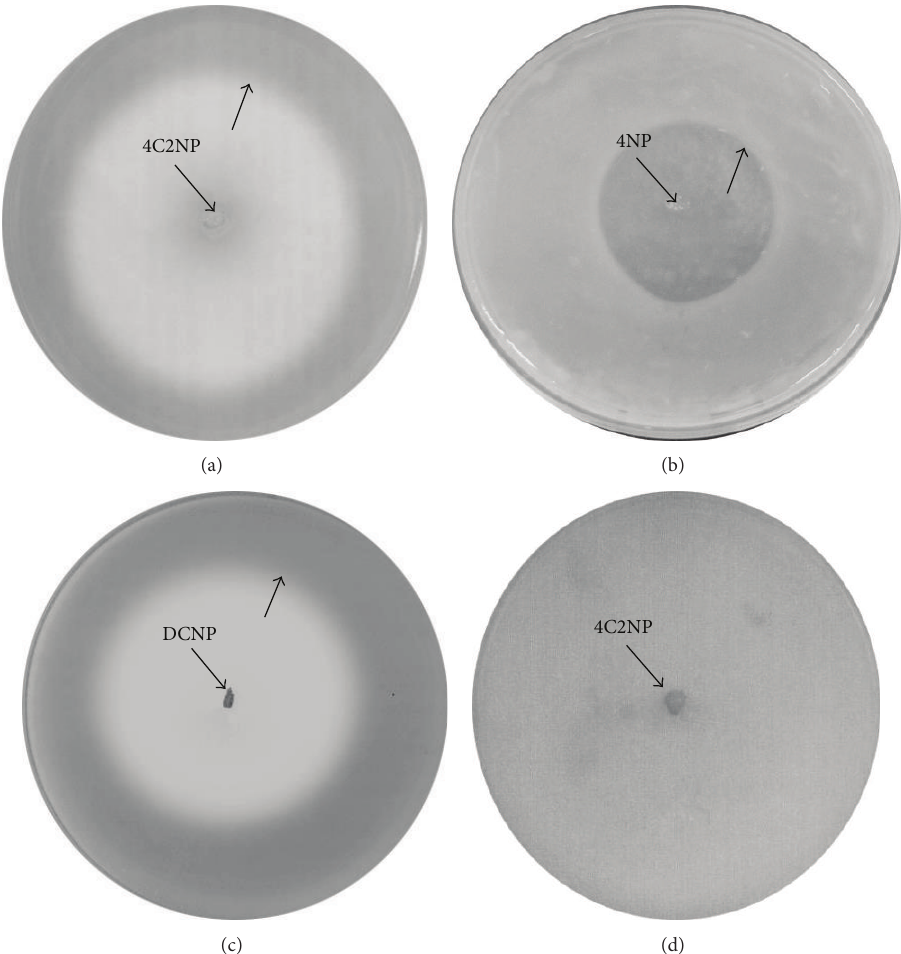
Figure 1: Drop plate assay demonstrating negative chemotaxis of (a) 4-chloro-2-nitrophenol, (b) 4-nitrophenol, and (c) 2,6-dichloro-4- nitrophenol by Bacillus sp. strain PA-2. In the control (d), there was no chemotaxis away from 4-chloro-2-nitrophenol by the heat-killed cells of strain